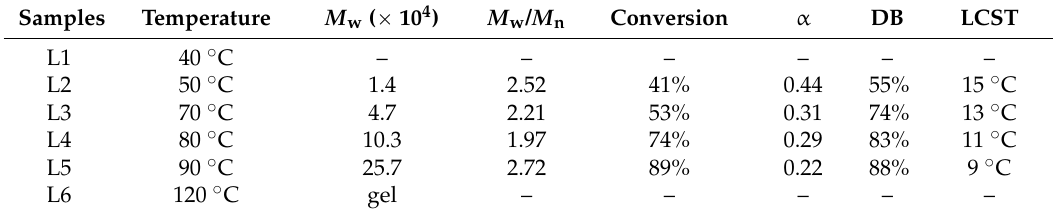
Table 2. Effect of reaction temperature on polymerization.